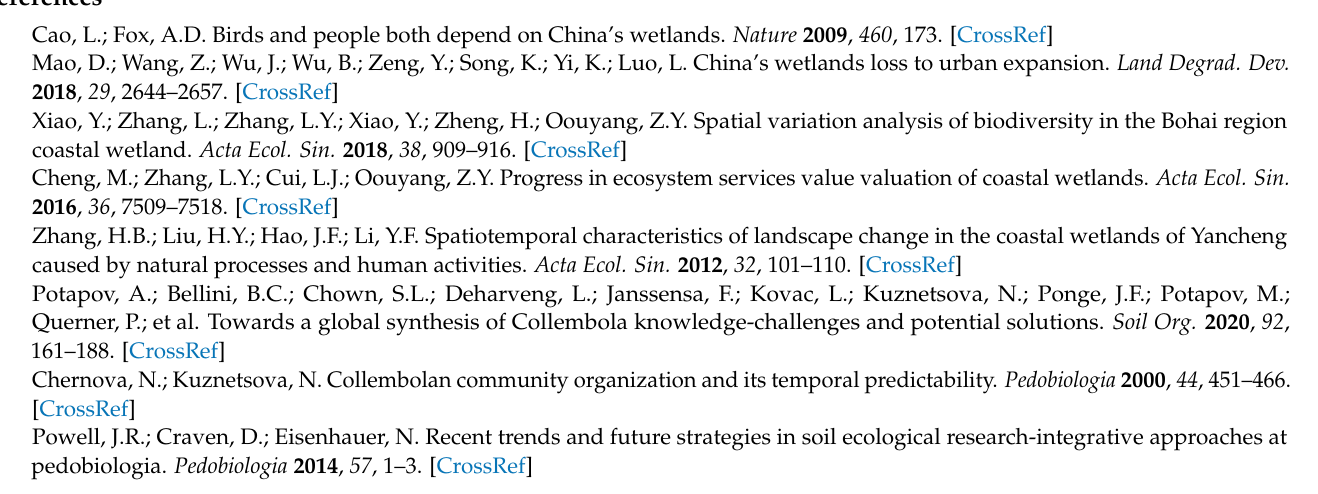
table; Table S2: ANOVA table of F- and p -values of linear mixed effects models on the effects of invasive plant species (plant; native plant species and invasive species) and tidal flats (tidal flat; low-tidal flats and high-tidal flats) on the soil